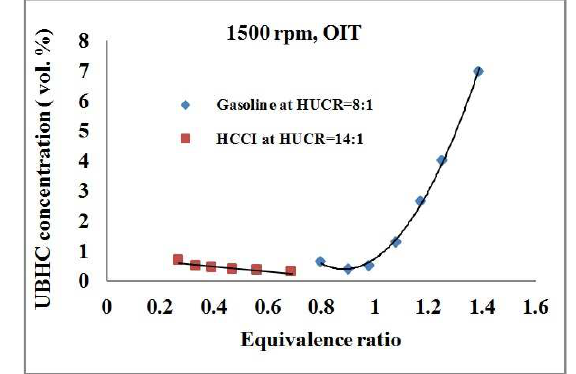
Fig. 12. CO concentrations of the two systems at 2 HUCR for each one, for wide range of equivalence ratio.